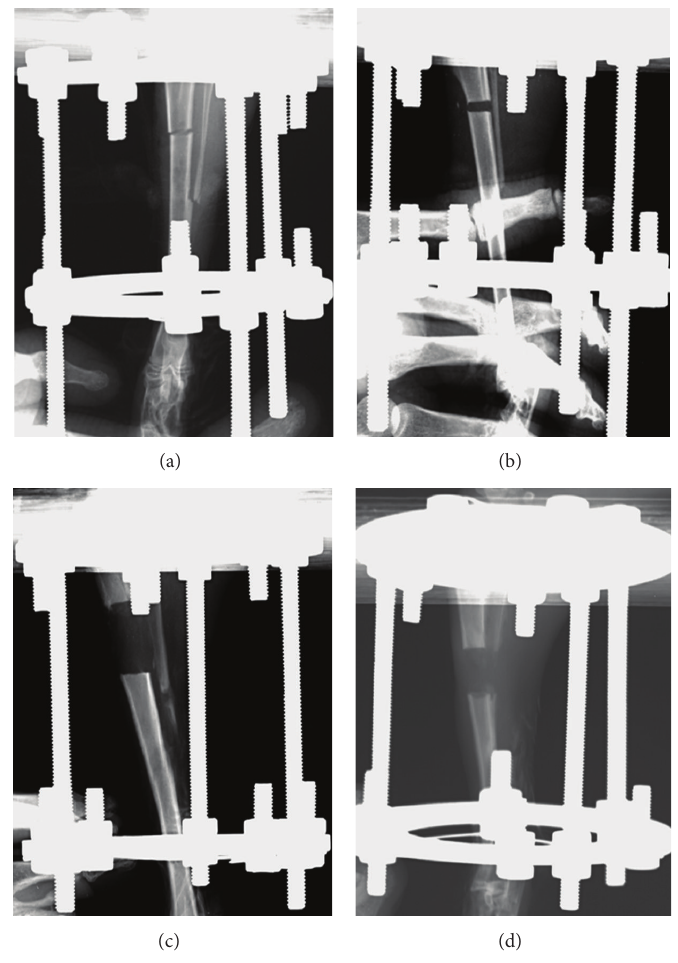
Figure 7: The X-ray image of rabbit tibia of different group immediately taken after the surgery. is relatively slow and there are more complications